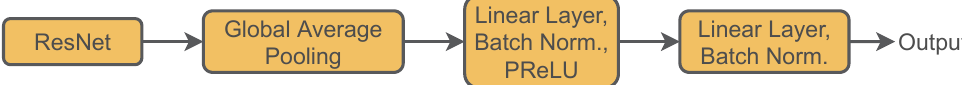
Figure 4. The figure illustrates the building blocks of the embedding